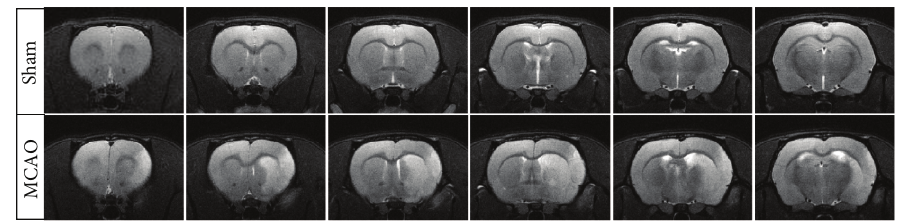
Figure 1: Corticostriatal lesion. Representative 𝑇 2 -weighted magnetic resonance images of coronal sections acquired 24 hours after MCAO.